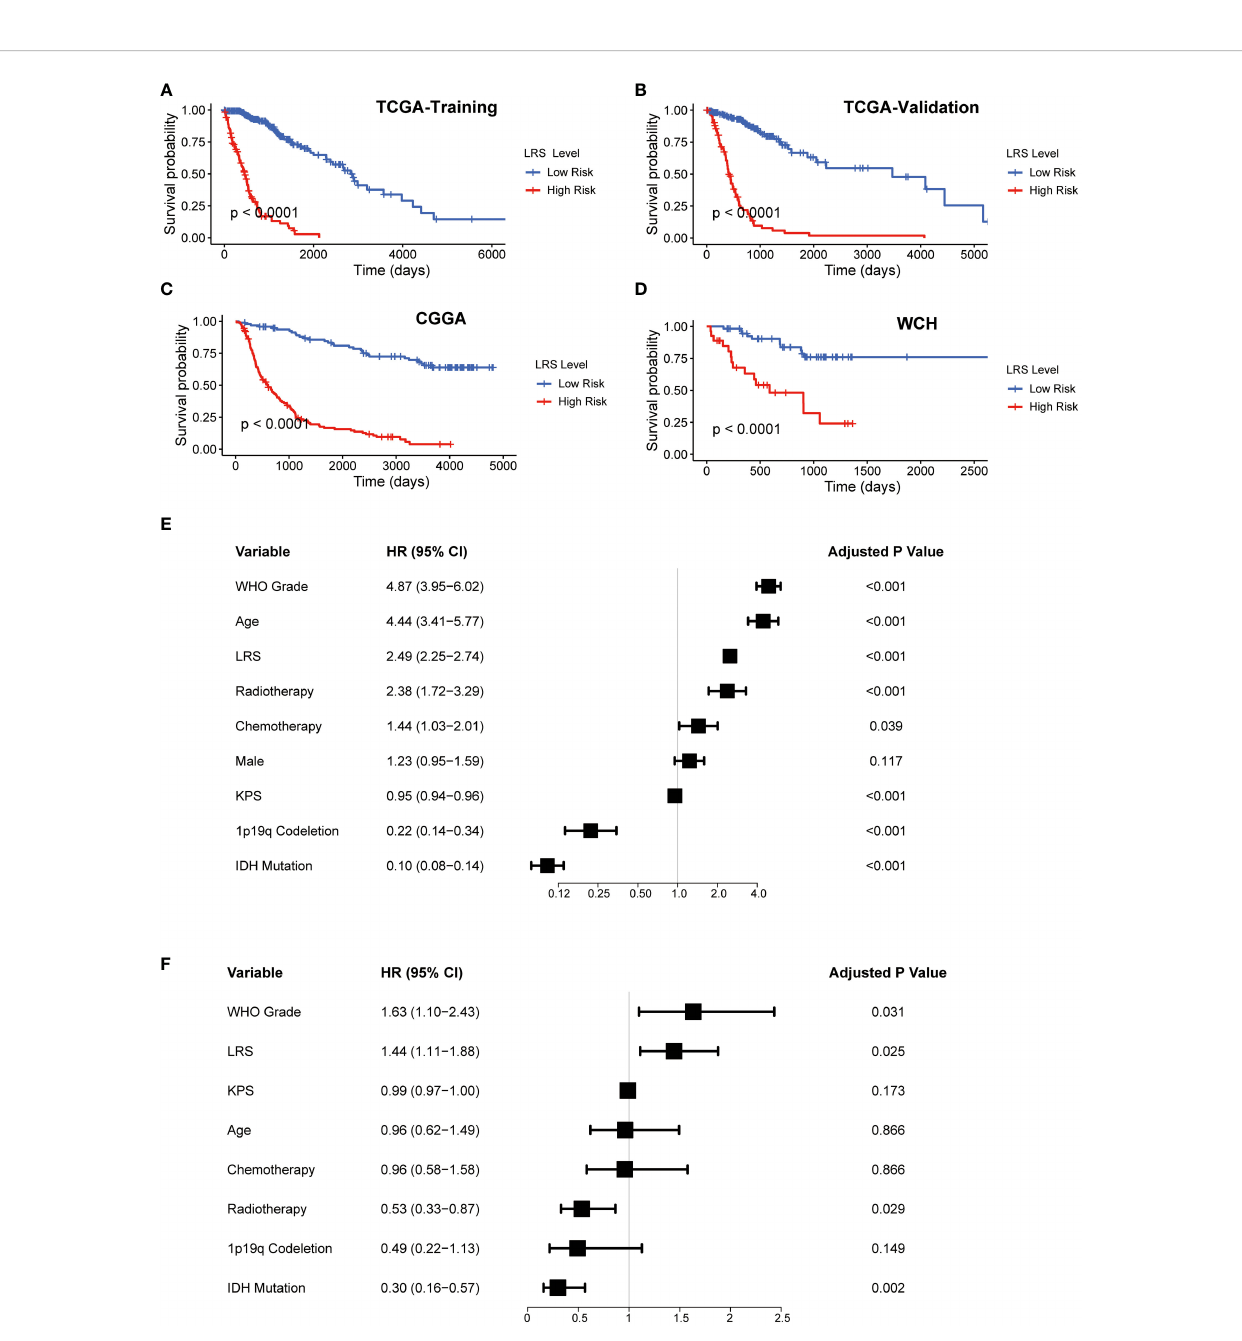
FIGURE 3 Prognostic value of LRS. (A-D) , K-M curves for assessing LRS in TCGA-training group, TCGA-validation group, CGGA, WCH cohort respectively; (E) , Univariate Cox regression of clinical variables in entire TCGA cohort; (F) , Multivariate Cox regression of clinical variables with a p value <0.1 in univariate Cox regression in entire TCGA. LRS, lipid metabolism risk score; K-M, Kaplan-Mier; TCGA, The cancer Genome Atlas; CGGA, Chinese Glioma Genome Atlas; WCH, West China